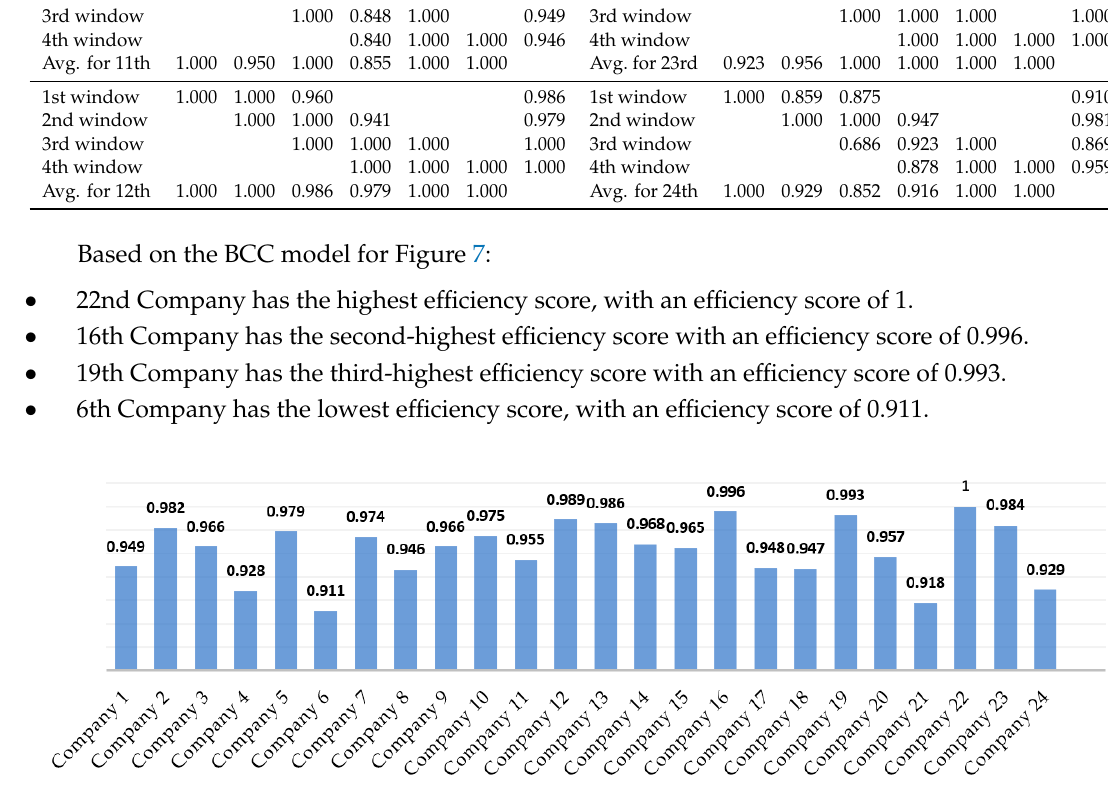
Figure 7. Average of total efficiency for the BCC model.